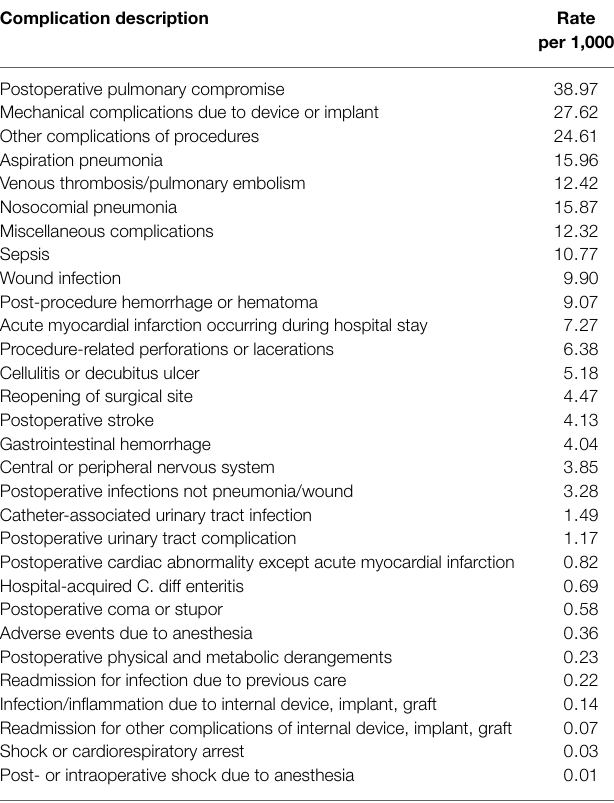
TABLE A1 | Complications per 1,000 patient encounters for spinal disease 2005–2011